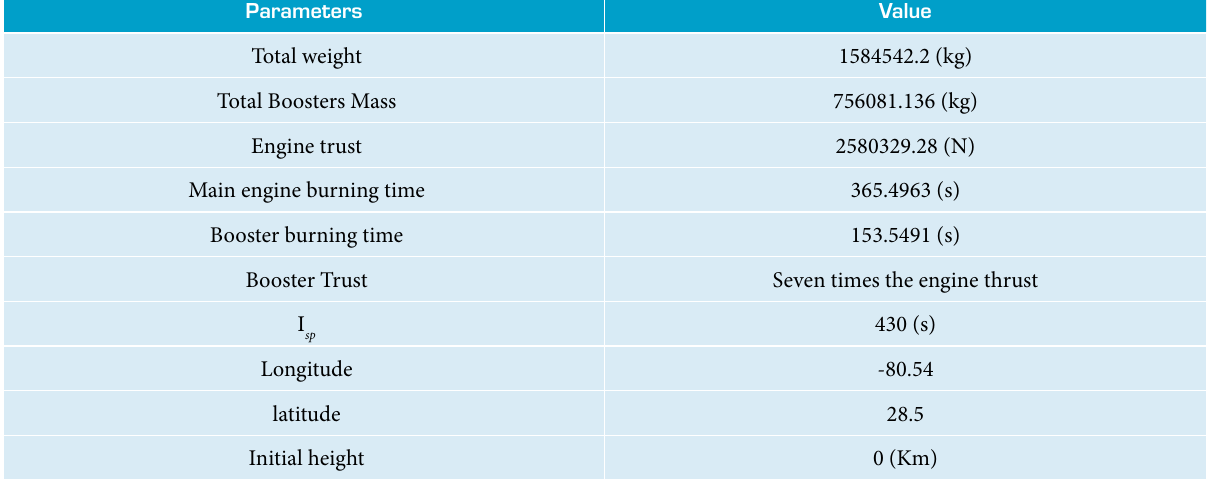
Table 2. The SLV parameters required for